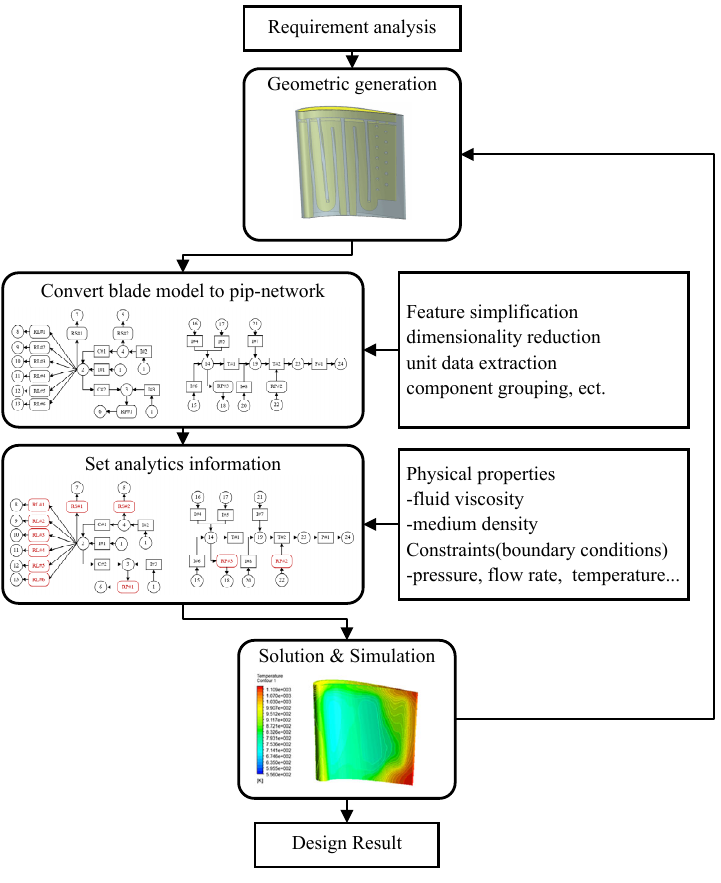
Figure 1. Diagram of the blade’s